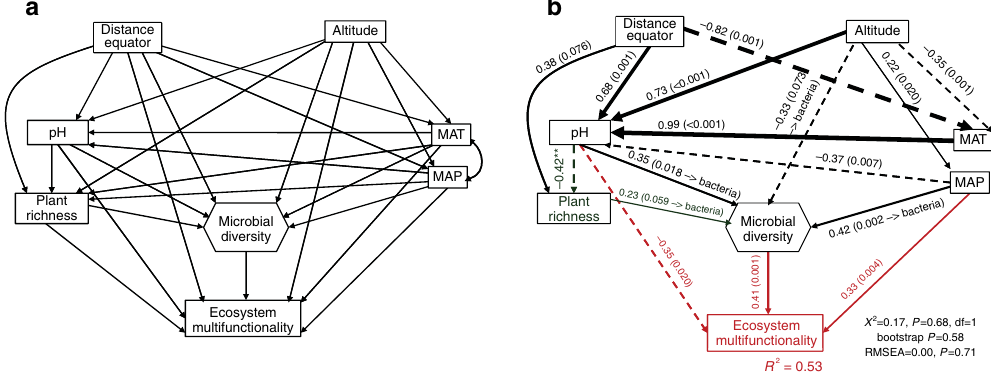
Figure 4 | Direct and indirect effects of space, climate, soil pH, plant richness and microbial diversity on ecosystem multifunctionality in global drylands. A priori ( a ) and final ( b ) structural equation models including plant richness as a predictor of ecosystem multifunctionality are shown. Numbers adjacent to arrows indicate the effect-size of the relationship. Continuous and dashed arrows indicate positive and negative relationships, respectively. The width of arrows is proportional to the strength of path coefficients. R 2 denotes the proportion of variance